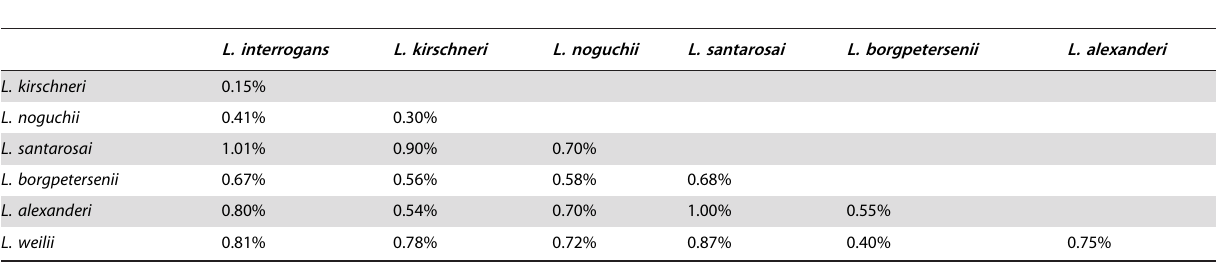
Table 4. Average nucleotide distance based on the near-full length rrs gene *